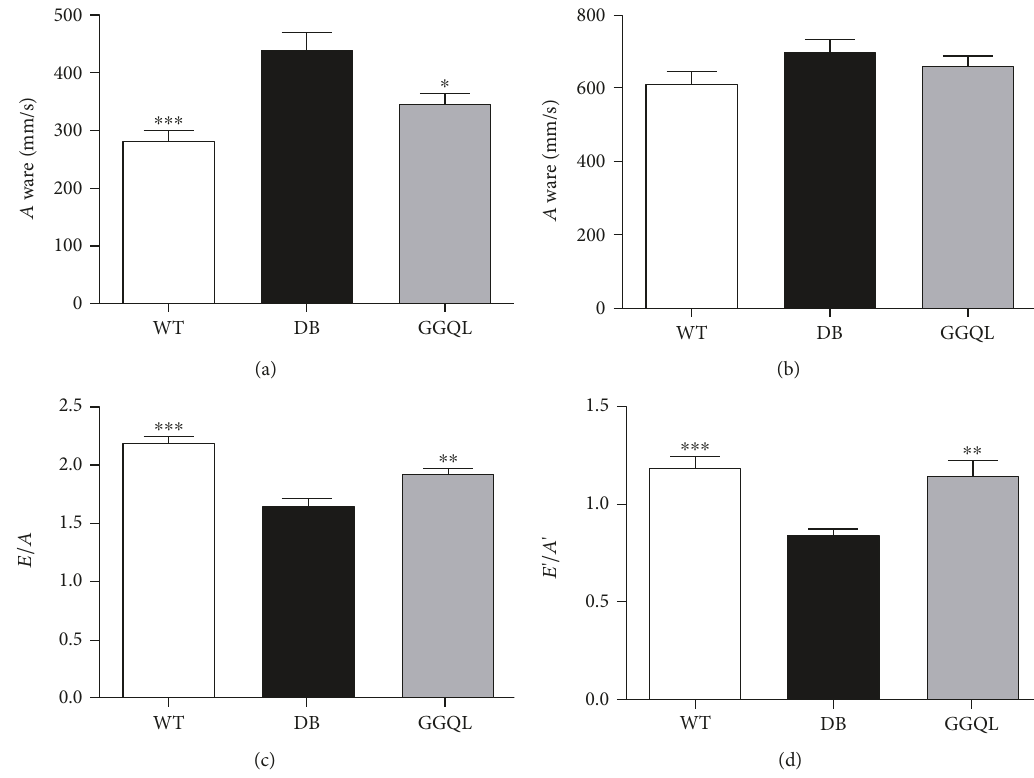
Figure 2: The results of cardiac function detected by echocardiograph. (a) E wave, (b) A wave, (c) E / A ratio, and (d) E ’ / A ’ ratio in each group ( n = 9 ). The DB group was the reference group to calculate P values, ∗ P < 0 05 , ∗∗ P < 0 01 and ∗∗∗ P < 0 001